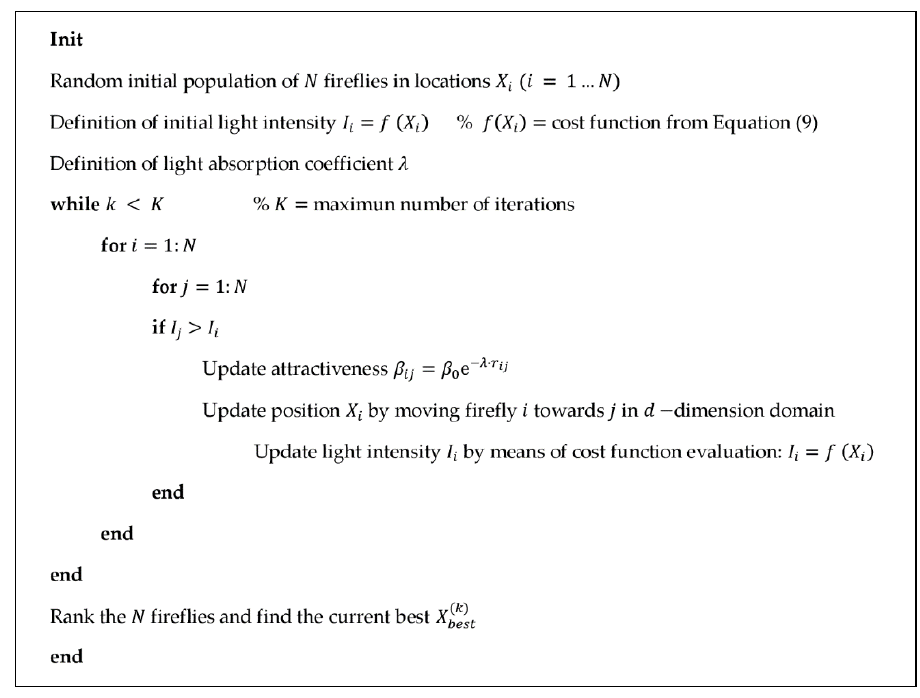
Figure 4. A pseudocode for the considered firefly algorithm implementation.